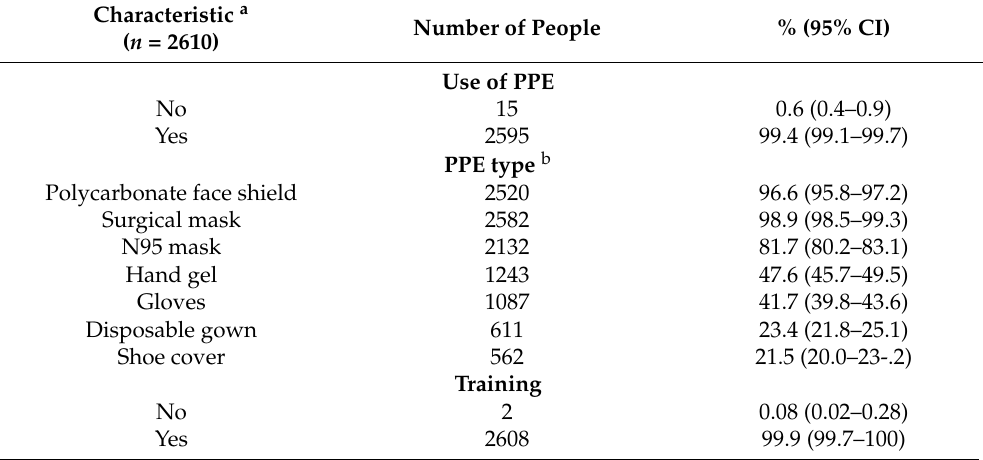
Table 3. Personal protective equipment and training received by